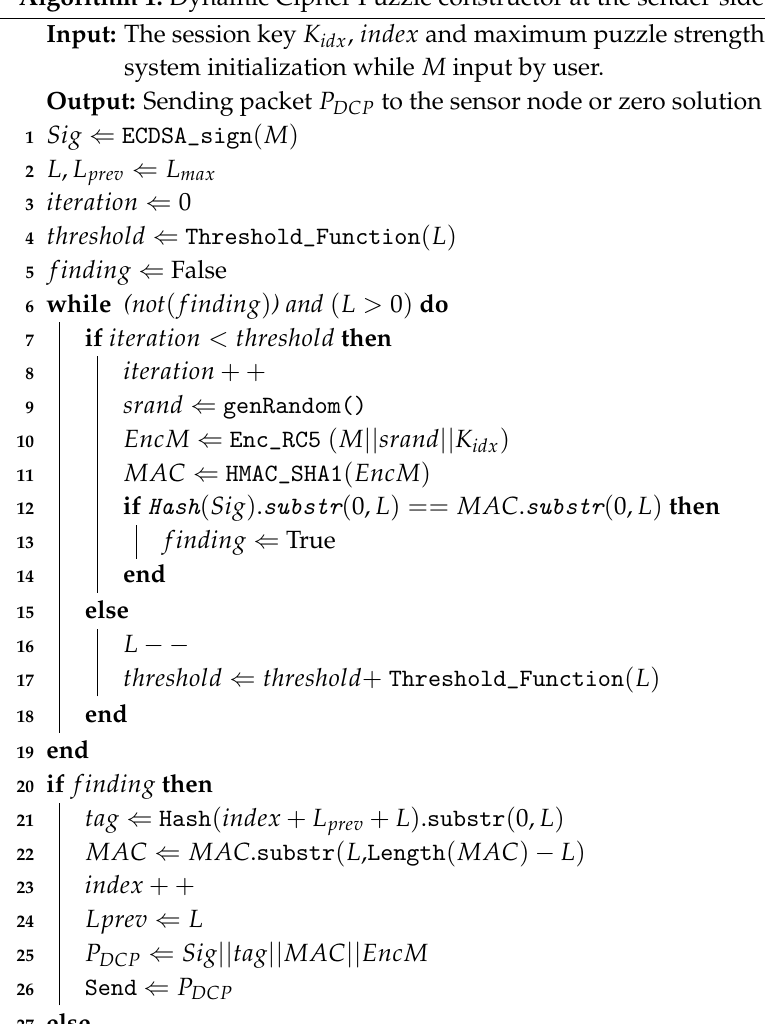
Algorithm 1: Dynamic Cipher Puzzle constructor at the